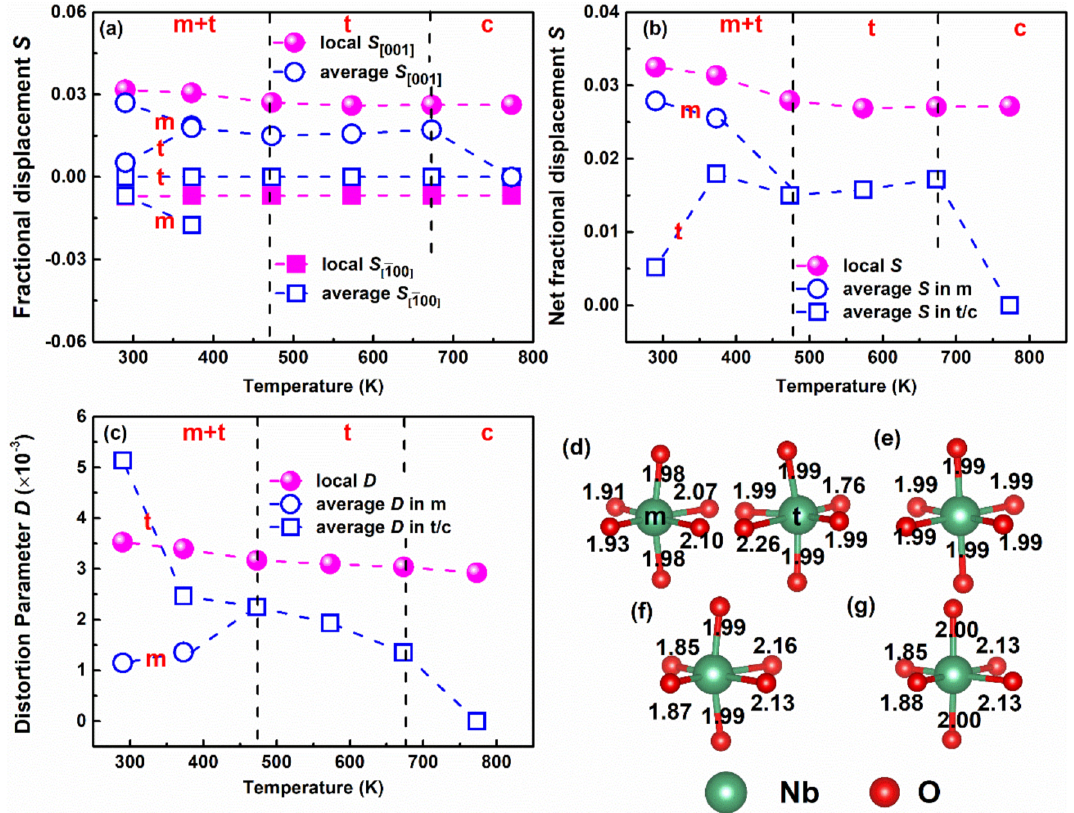
Figure 6. Atomic displacement and octahedral distortion as a function of temperature: ( a ) Nb fractional displacement (cid:2) (cid:3) (cid:0) (cid:1) S along 100 and [001] (S 001 ) directions, and ( b ) net Nb fractional displacement as a function of temperature from 290 100 to 773 K. ( c ) Octahedral distortion parameter as a function of temperature from 290 and 773 K for the local and average structures. Note that open blue symbols represent parameters obtained from average Rietveld refinement, while the closed pink symbols represent parameters obtained from PDF refinement in the r range of 1.7–10 Å. ( d , e ) Illustration of the NbO6 octahedron in the average structure at 290 (left top) and 773 K (right top), respectively. ( f , g ) Illustration of the NbO6 octahedron in the local structure at 290 (left bottom) and 773 K (right bottom), respectively. The indicated Nb-O bond lengths in ( d – g ) are in the Angstroms